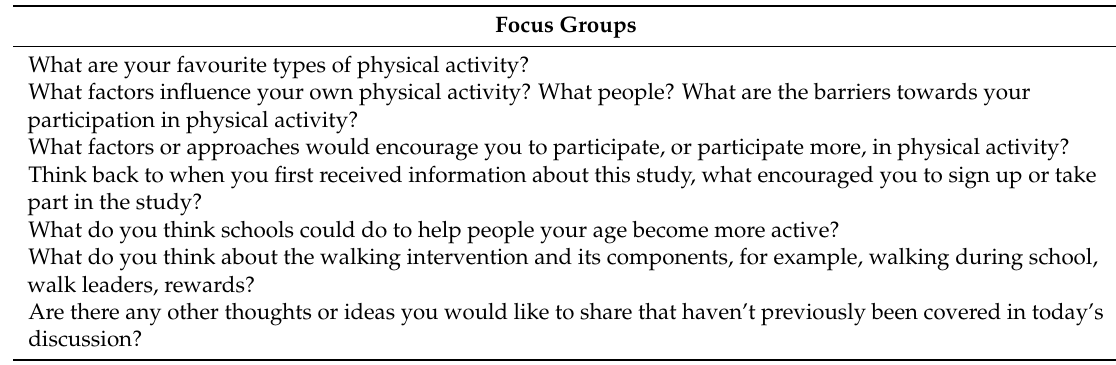
Table 1. Semi-structured discussion guide for focus